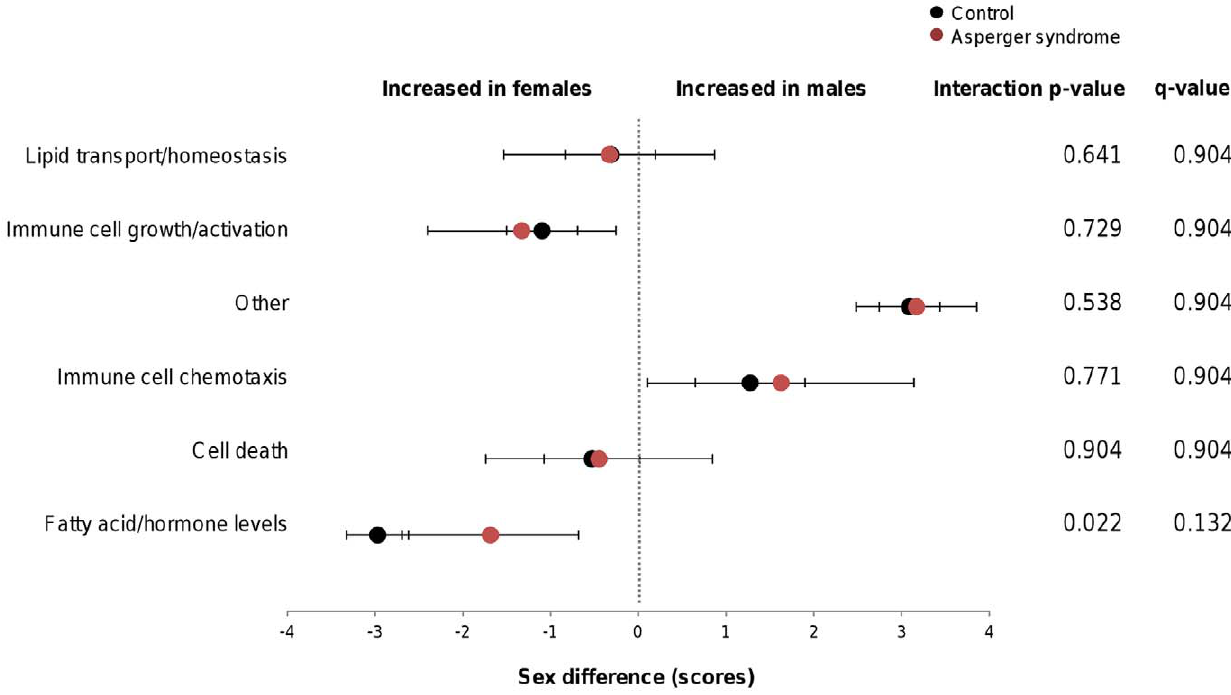
Figure 2. Sex differences of composite variables summarizing analyte clusters. Values for typical individuals were pooled across nine cohorts; values for Asperger syndrome participants were calculated from cohort 10. The x-axis shows the difference between composite values that reflect the average molecular levels in males and females. Horizontal bars indicate 95% confidence intervals of the difference between sexes.